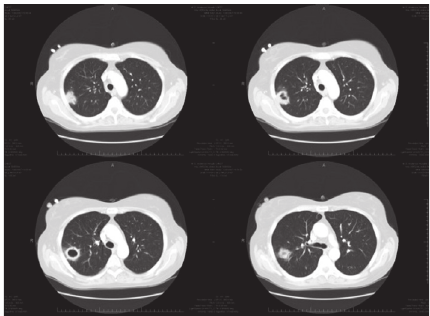
Figure 1: Computed tomography scan sections of the lungs showing right-sided cavitary nodule abutting the chest wall.